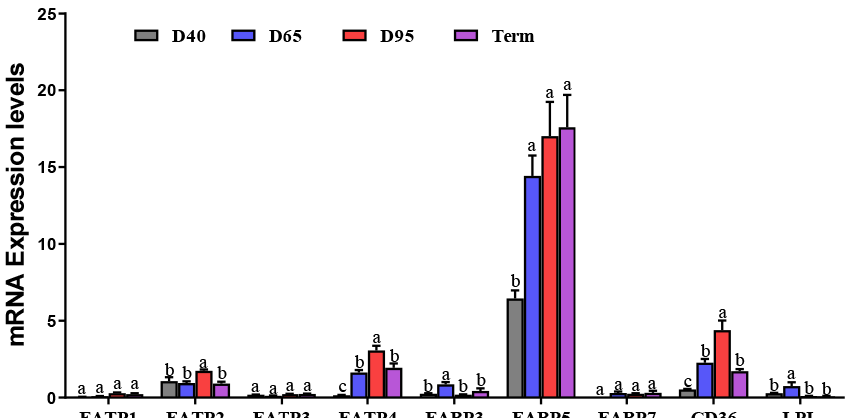
Figure 2. The mRNA expression levels of FA transport-related genes in porcine placentae at different gestation periods. Values are presented as mean ± standard error of the mean (SEM). Values labeled with different letters mean they are significantly different ( p < 0.05) within the same gene group. Values labeled with the same letter mean they are not significantly different ( p > 0.05) within the same gene group.